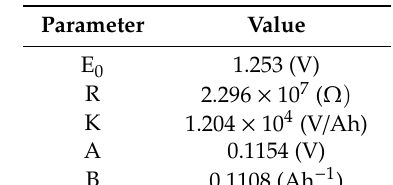
Table 1. Parameter from 0.2 C discharge curve.